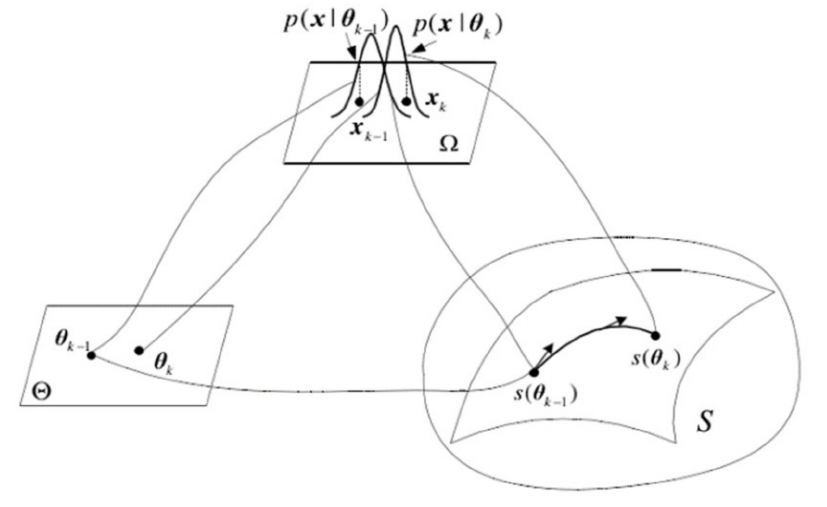
Figure 2. Schematic diagram of the statistical